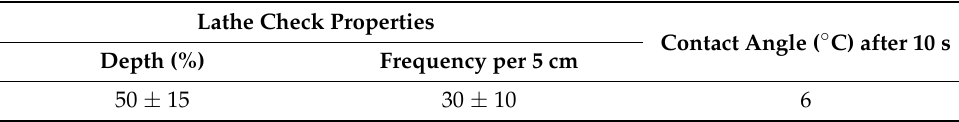
Table 1. Properties of spindleless rotary-peeled veneers with 2 mm thickness recovered from short- rotation Hevea plantation logs